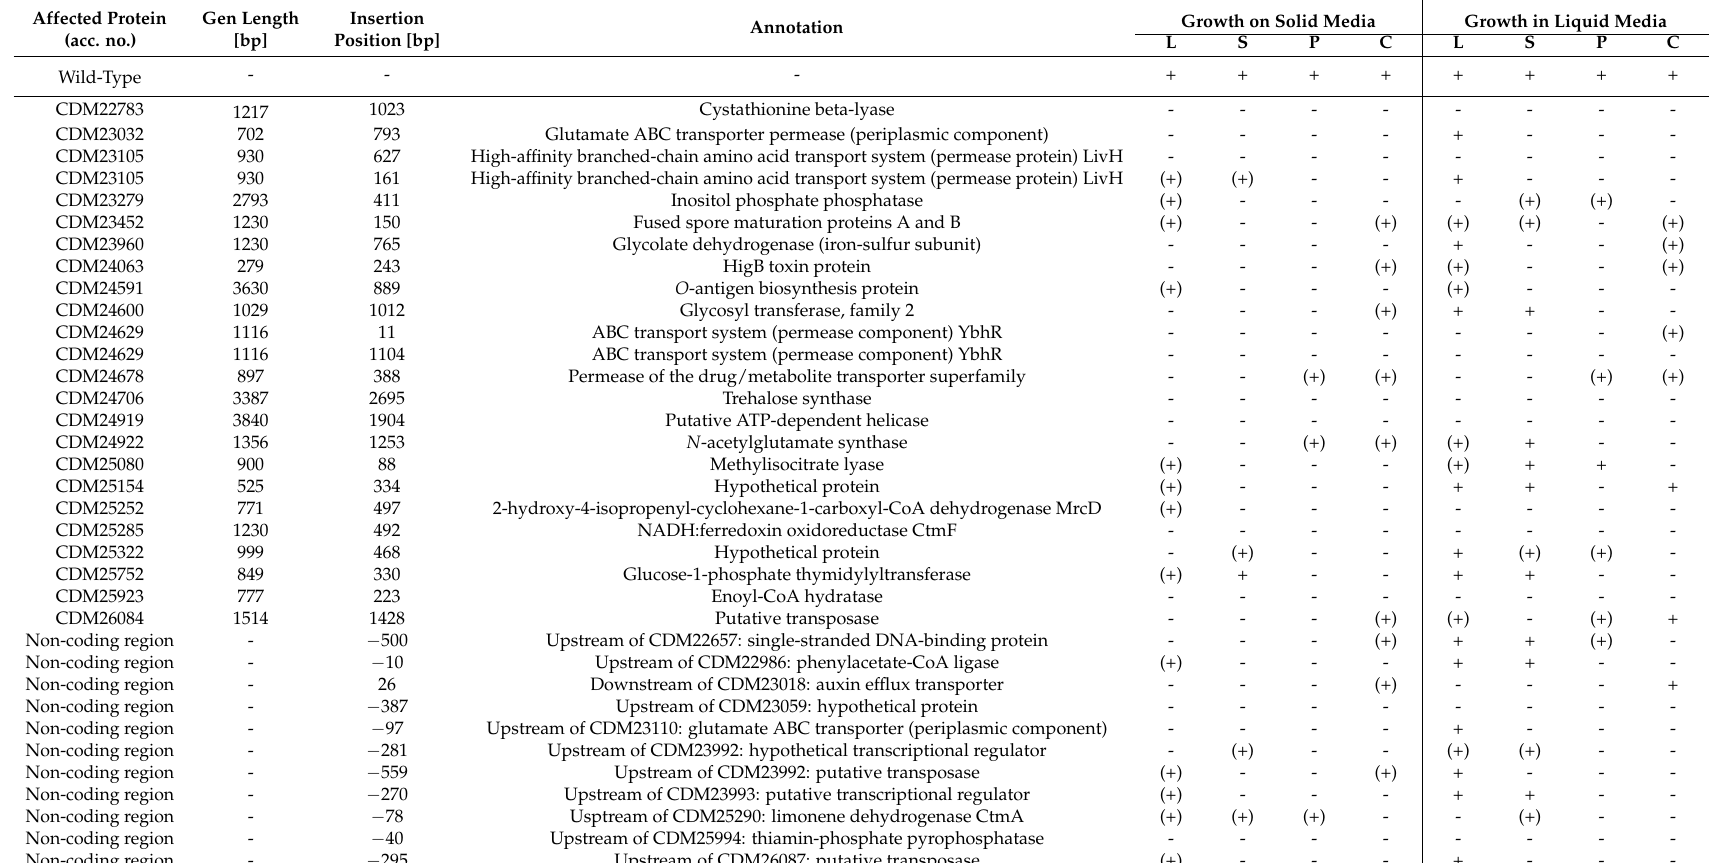
Table 3. Genetic and physiological features of C. defragrans 65Phen transconjugants affected in the metabolism of monoterpenes. Growth on monoterpenes was tested on solid and in liquid media. Carbon sources: L, R-(+)-limonene; S, sabinene; P, α -pinene; C, 3-carene. Growth quantification in liquid was based on ∆ OD 600 : + = ∆ OD 600 ≥ 0.15; (+) ≥ 0.05; - < 0.05. Affected Protein (acc.